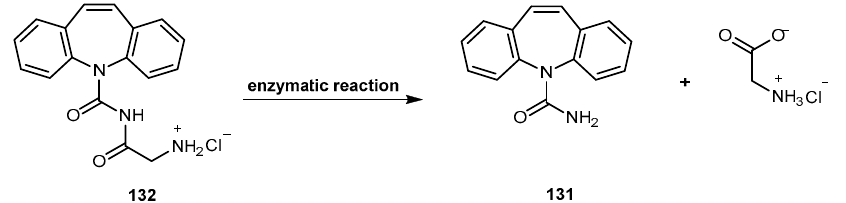
Figure 52. Bioconversion of N -Gly-CBZ ( 132 ) to CBZ ( 131 ) in vivo (Adapted from [4]).